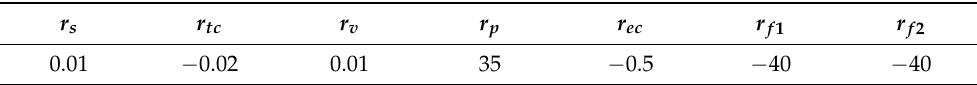
Table 4. The rewards values used for the network training.